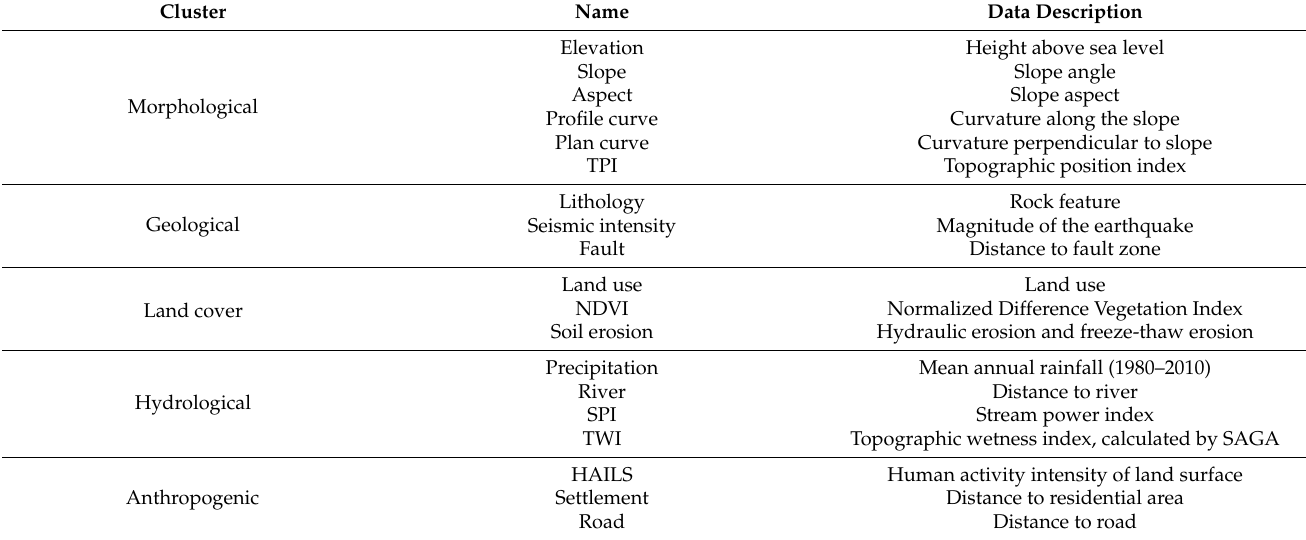
Table 1. The names, structures, and descriptions of conditional